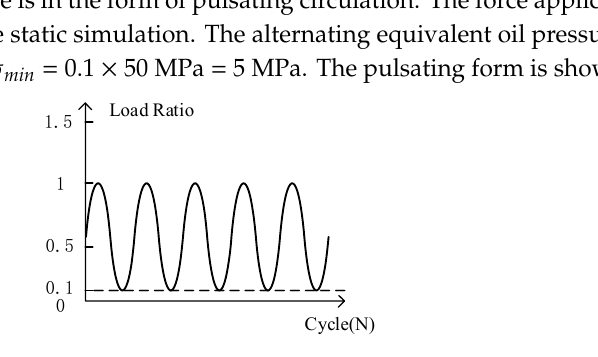
Figure 9. Constant amplitude load ratio.